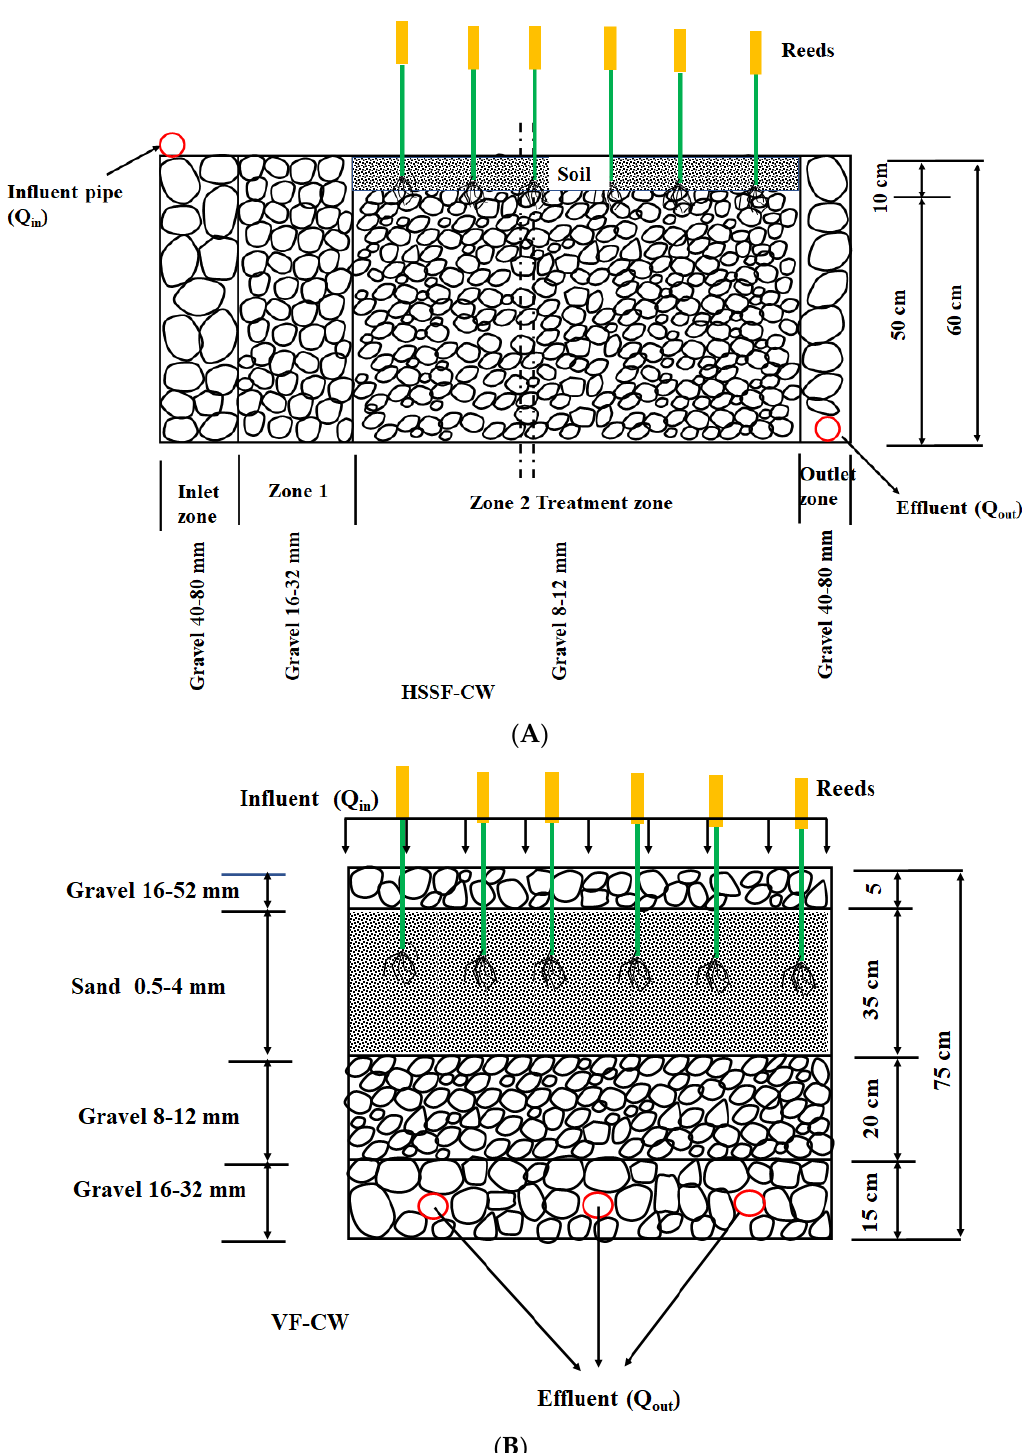
Figure 2. Detailed drawing of HSSF-CW and VF-CW beds media. ( A ) HSSF-CW and ( B ) VF-CW. 2.5. Modeling HSSF-CW and VF-CW Efficiencies Using the P-K-C*